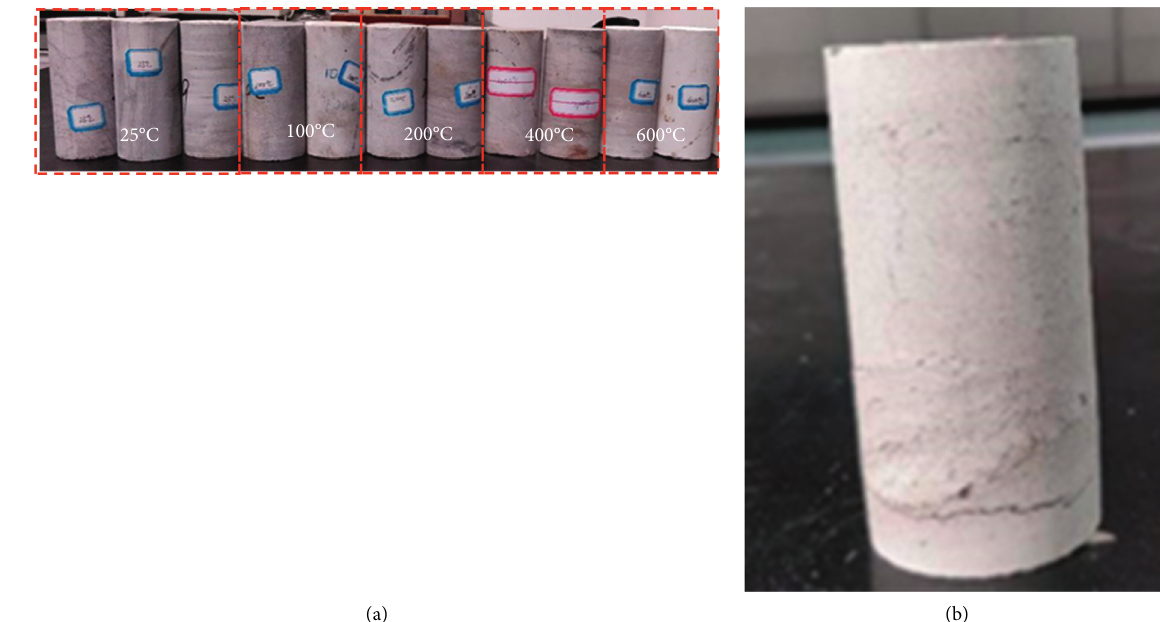
Figure 5: Rock sample for uniaxial compressive strength test after undergoing various temperatures. (a) Rock sample after experiencing the temperature from 25 ° C to 600 ° C. (b) Rock sample after undergoing 800 ° C.